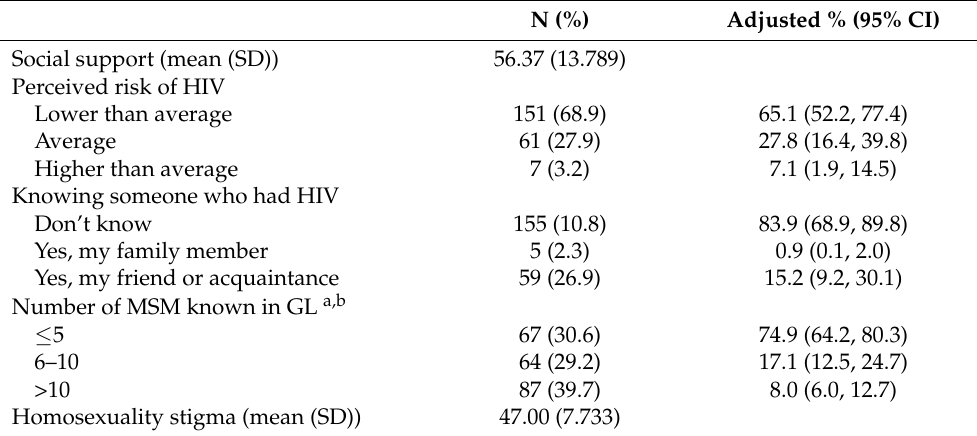
Table 3. Crude and adjusted awareness, psychosocial factors, and behavior among men who have sex with men in Guilin, China ( n =